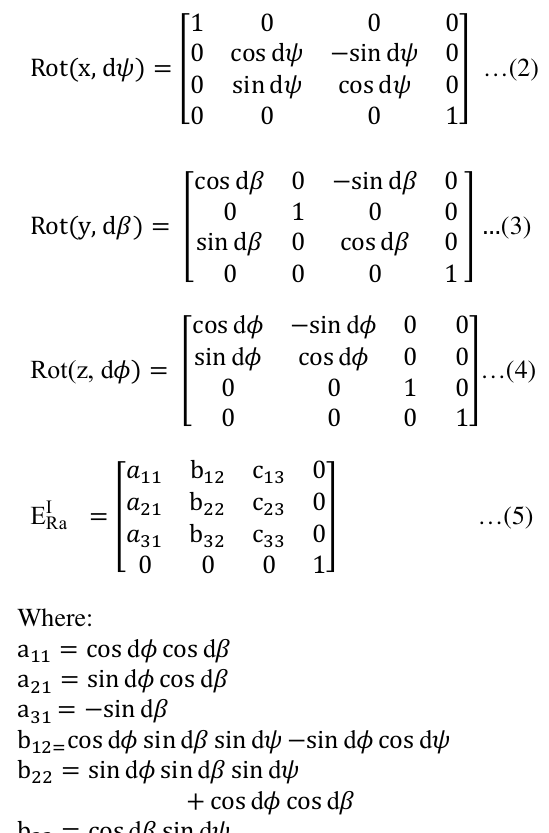
The transformation equation between the a and O I consists of two parts, coordinates O rotation and translation. According to the Euler (cid:2) (cid:2) angle principle, the rotation part is the result of three sets of rotations which are roll, pitch and yaw about the axes z, y, x, respectively. The sequence of rotation is: …(1) RaI E (cid:7) Rot (cid:10)z, d(cid:14)(cid:15) Rot(cid:10)y, d(cid:17)(cid:15) Rot(cid:10)x, d(cid:19)(cid:15) That is a rotation of about the x axis, followed by a rotation d about the y axis and d(cid:19) finally a rotation of d about the z